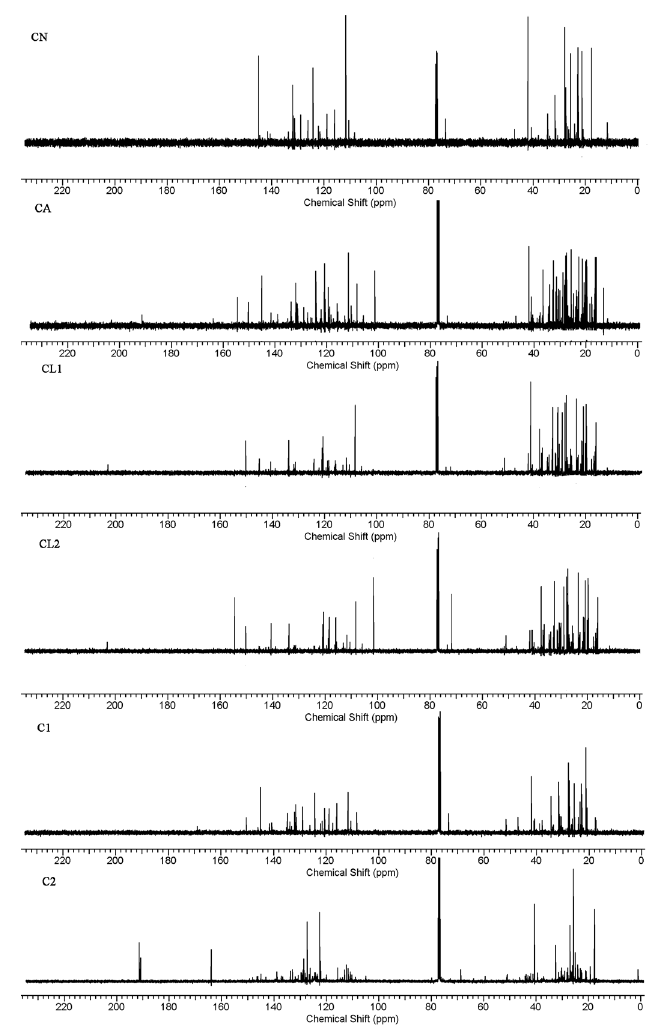
Fig. 1: 13 C spectra of Citrus spp.